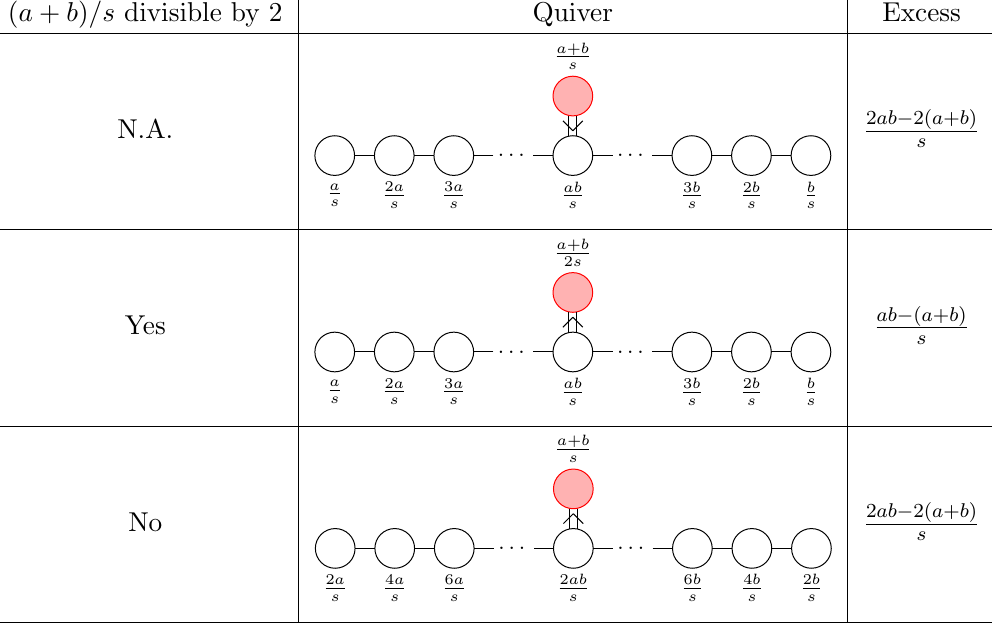
Table 12 . Exotic minimally unbalanced quivers with G = SU( n ), n = a + b and a double laced edge. s is the greatest common divisor of a and b .